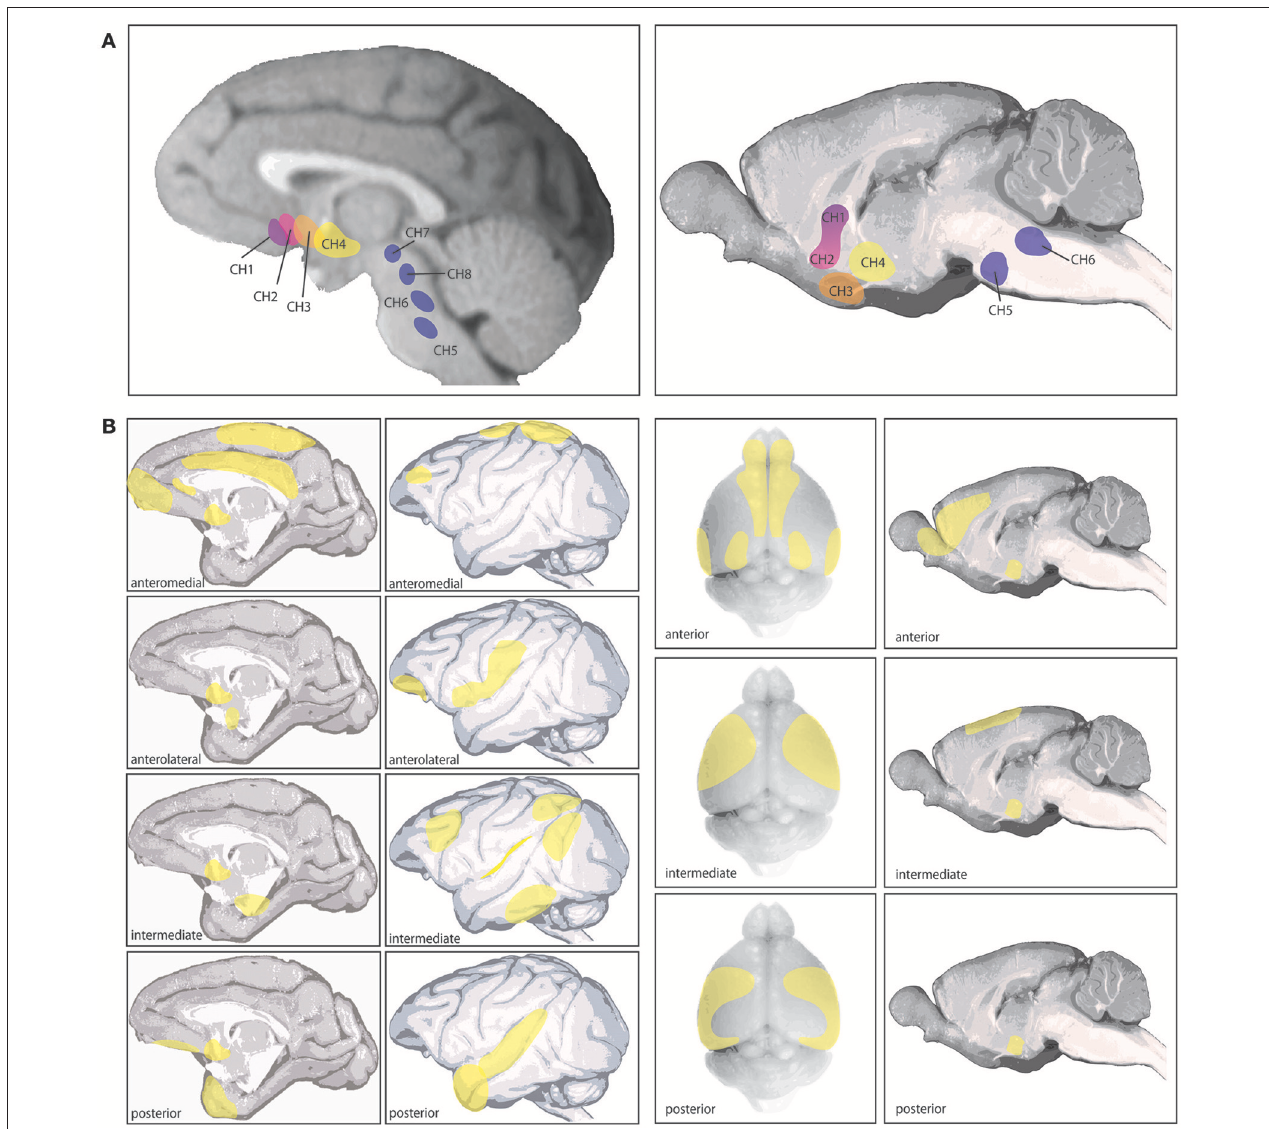
FIGURE 1 | Cholinergic nuclei and cortical cholinergic projections as detailed in (Mesulam et al., 1983a,b; Luiten et al., 1987). (A) The left shows the 8 different cholinergic nuclei in primate brain, referred to as Ch1-8 (see text), and the right image shows the corresponding 6 cholinergic nuclei in rat brain. The 4 nuclei comprising the basal forebrain are Ch1-4. (B) The left shows the specific cortical projection patterns of the four distinct subsections of the Ch4 nucleus corresponding to the Nucleus Baysalis of Meynert (see text), based on those reported by Mesulam et al. (1983a). Ch4 anteromedial primarily projects to the midprincipalis, medial frontal pole, subcallosal gyrus, cingulate, dorsomedial motor cortex, and medal parietal cortex (areas 5 and 7). The anterolateral subsection projects to lateral area 12, frontal operculum, ventral S1, ventral posterior parietal cortex and the amygdala. The intermediate Ch4 region was further divided by Mesulam et al. (1983a) into a dorsal and ventral portion, which are combined here. The combined intermediate region innervates the ventrolateral orbital cortex, insula, periarcuate, posterior principalis, inferior parietal lobule, peristriate visual cortex, inferior temporal cortex, and parahippocampal regions. The posterior Ch4 subsection projects to the auditory association cortex and temporal pole. The right section shows the cortical projections in rodent arising from Ch4, based primarily on those reported by Luiten et al. (1987). In rodent these projections show a gradient pattern with considerable overlap between subsections. The anterior division projects to infralimbic, prelimbic, anterior cingulate, agranular insula, orbitofrontal in some animals, olfactory tubercle, piriform cortex, entorhinal cortex, occipital cortex in some animals, and motor and somatosensory cortex in some animals. This subsection appears to be a transition area between the intermediate region and the HDB (not pictured) which overlaps with all anterior Ch4 projections except amygdala, which HDB does not innervate. The intermediate Ch4 subsection innervates medial and lateral precentral cortex, motor cortex, somatosensory cortex in some animals, agranular insula, and perirhinal regions. The posterior section projects to motor, lateral precentral cortex, somatosensory cortex, temporal cortex, perirhinal cortex, and agranular insula and occipital cortex in some animals. In rodent, all Ch4 subdivisions strongly innervate amygdala. As this review focuses on cholinergic actions in different cortical areas and across species, these cortical projections are of key relevance.